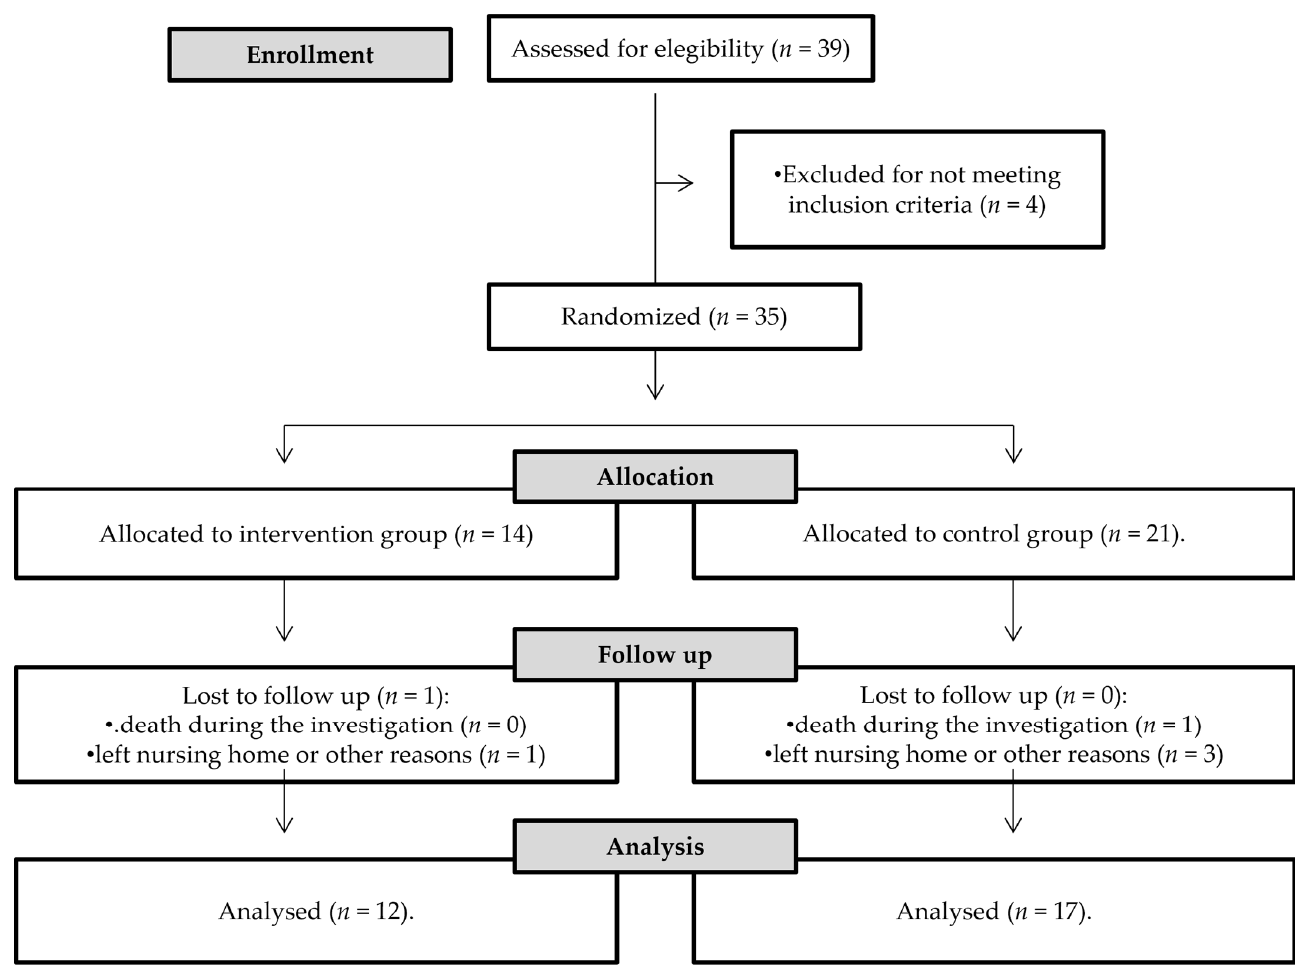
Figure 1. CONSORT diagram.